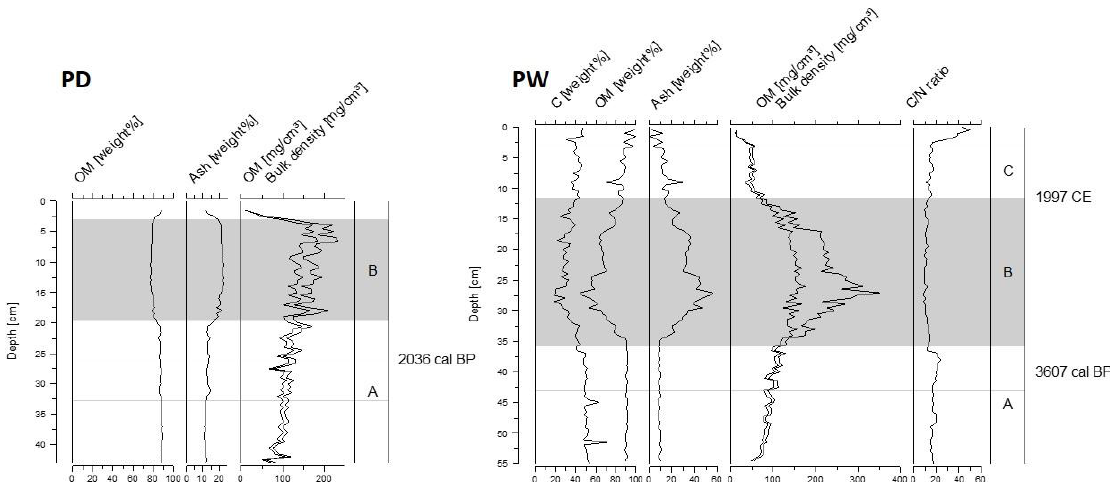
Figure 3. Profiles of weight% values of organic matter (OM) and ash, OM per volume, and bulk density for sites PD and PW and weight% values of carbon (C) and C/N ratio for PW.